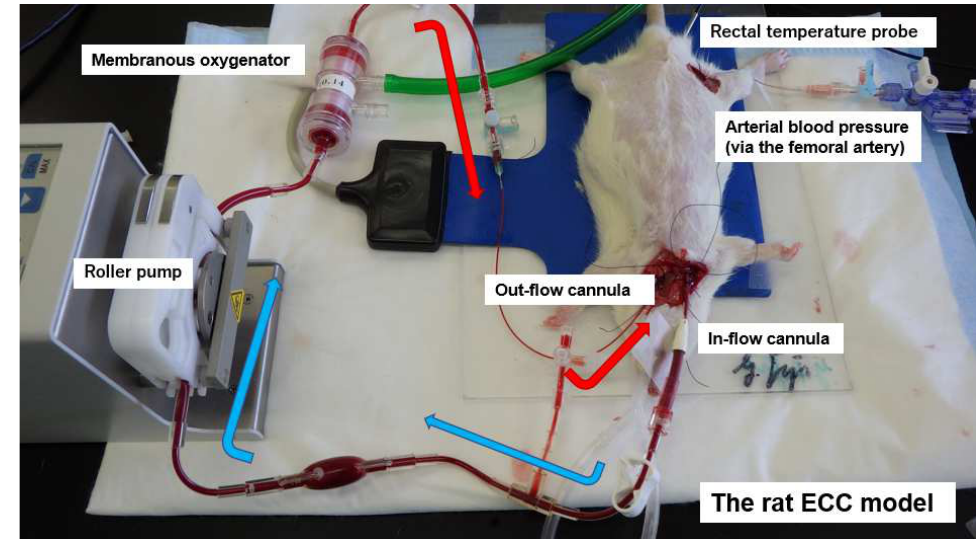
Figure 1. Extracorporeal circulation in a rat model.